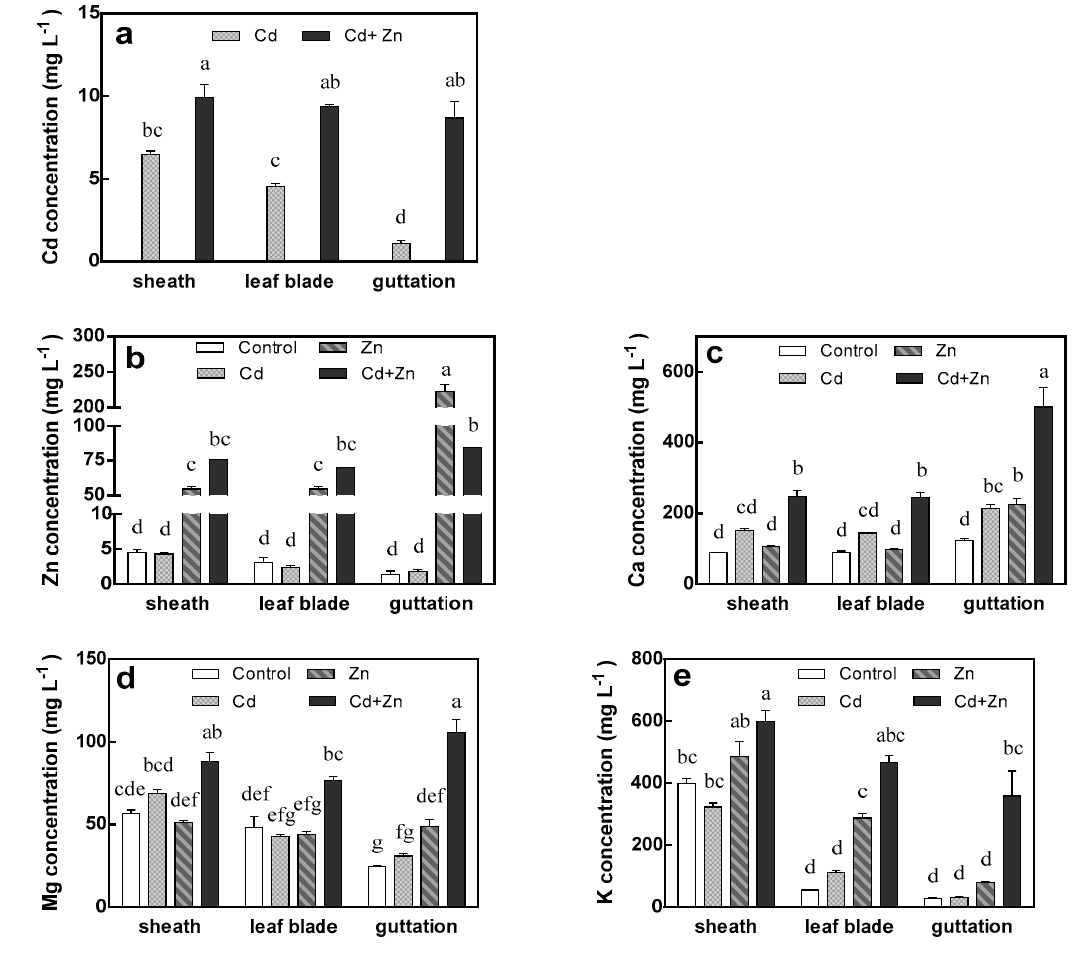
Figure 5. The concentrations of Cd ( a ), Zn ( b ), Ca ( c ), Mg ( d ) and K ( e ) in xylem sap of sheath, leaf blade and guttation of tall fescue. Plants were grown for 15 days in solutions under control (0 µ M Cd + 15 µ M Zn), Cd (75 µ M Cd + 15 µ M Zn), Zn (0 µ M Cd + 115 µ M Zn) and Cd + Zn (75 µ M Cd + 115 µ M Zn) treatments. Error bars represent ± SEM of three replicates. Means with a common letter did